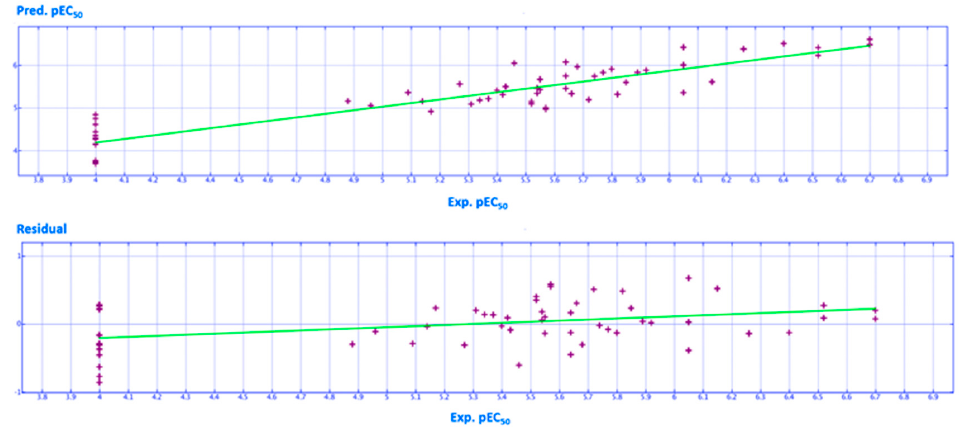
Figure 16. Distribution of the predicted (Pred.pEC 50 ) and experimental (Exp.pEC 50 ) potency values of the training set compounds (by violet crosses). Residual values are also reported, calculated as the difference between the Exp. pEC 50 and the Pred. pEC 50 .